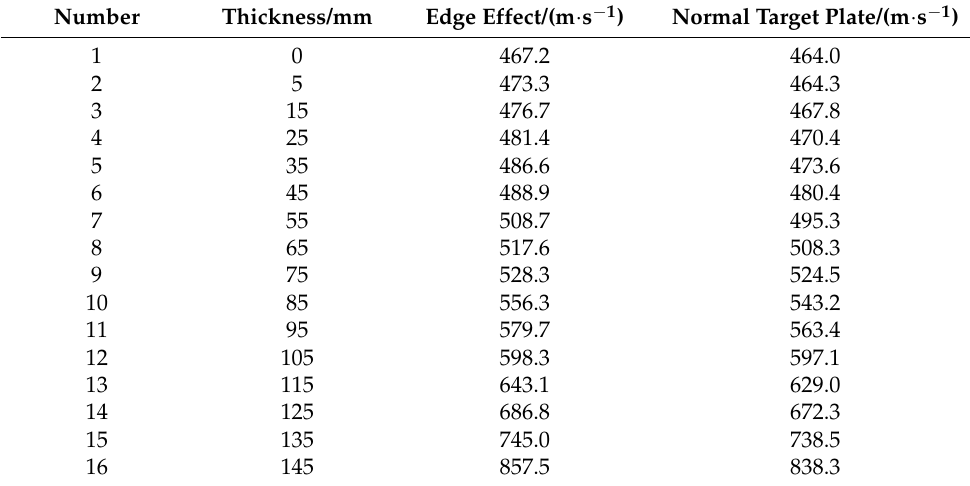
Table 5. Residual velocity considering edge effect and residual velocity of normal target plate.